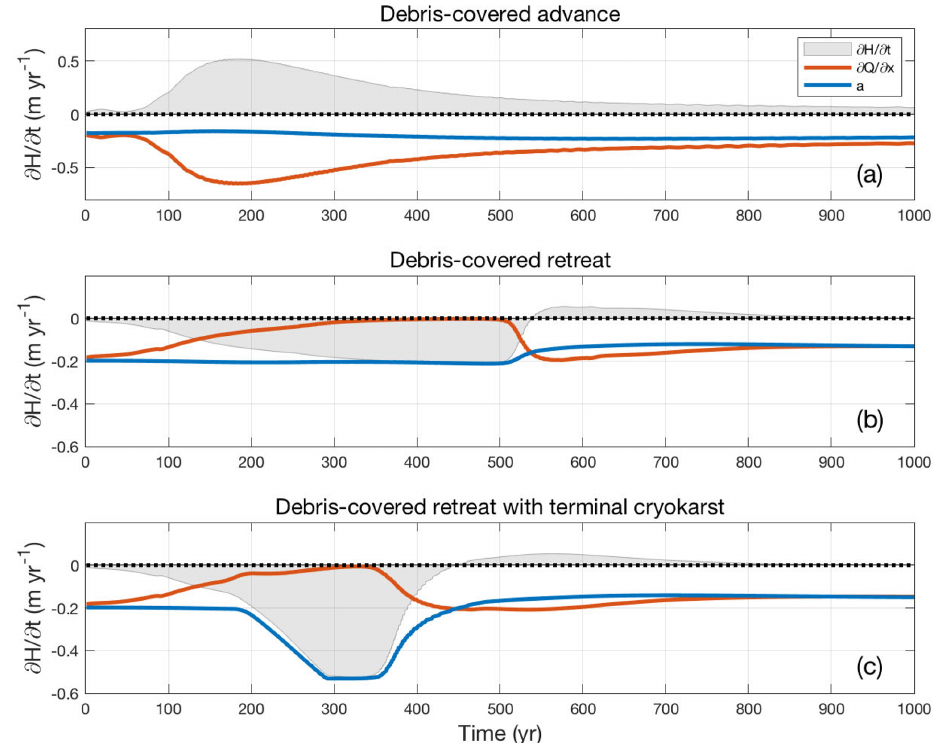
Figure 10. Thinning rate, flux divergence, and surface mass balance averaged over the final 200m of the glacier terminus before the terminus during advance (a) , retreat (b) , and retreat with cryokarst (c) , for c = 0 . 25%, λ m = 0 . 05, τ + initial condition is a steady state at ELA = 3050m followed by a 50m step change in ELA at time t =